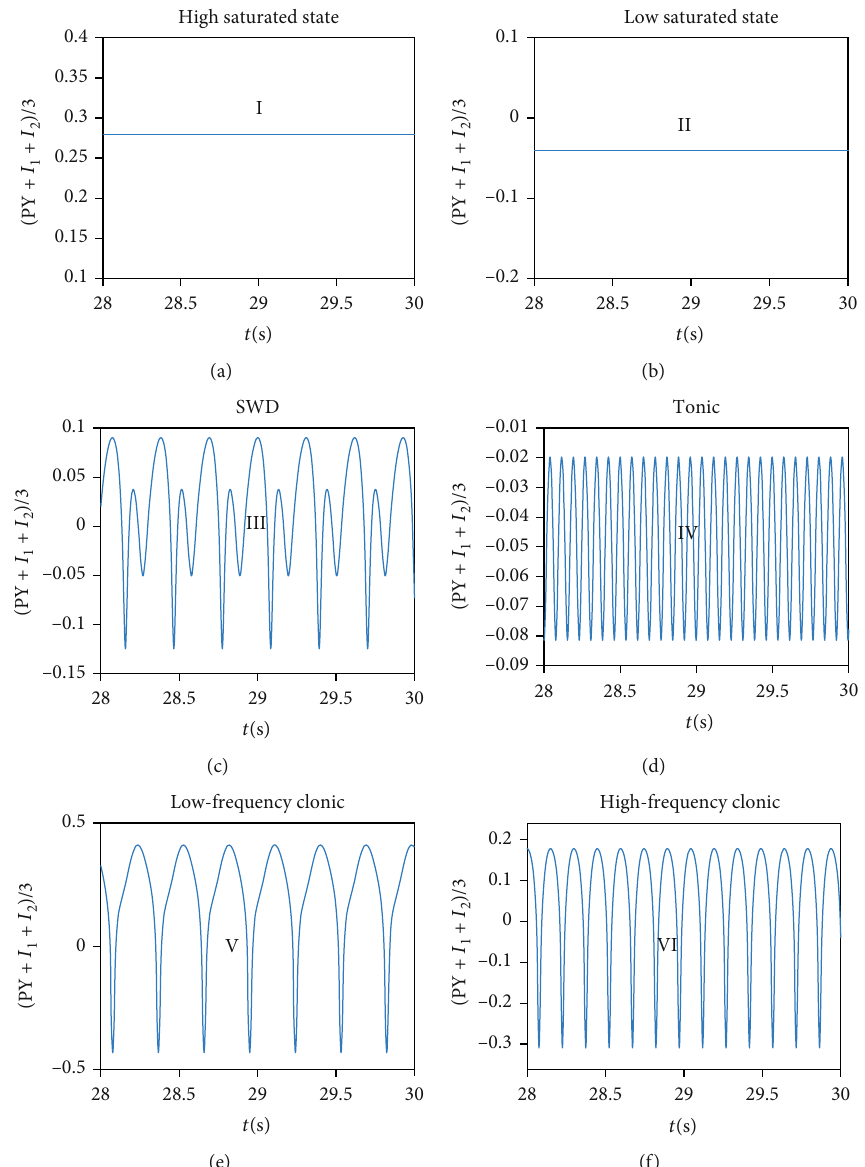
, C Þ = ð 6, 0 : 1 Þ ; (b) low saturated state, 7 11 , C Þ = ð 2, 1 Þ ; (f) high- 7 11